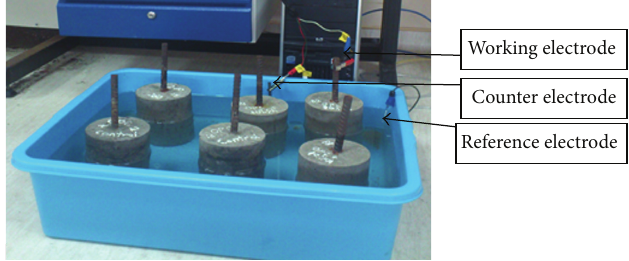
Figure 2: Setup of corrosion test.